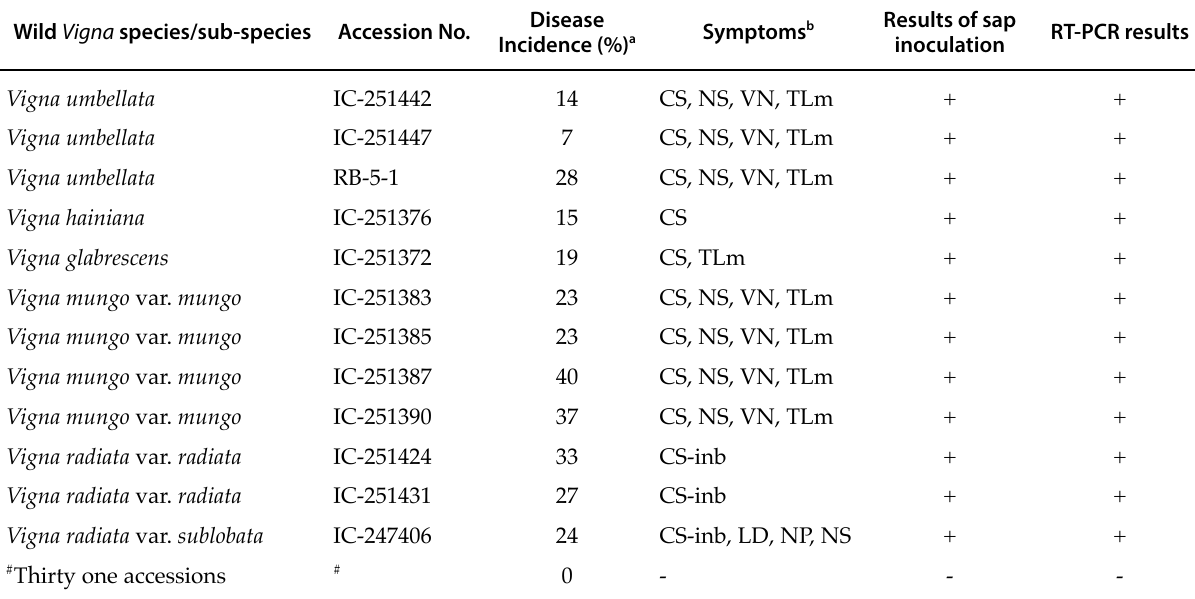
Table 2. Wild Vigna accessions, disease incidence, symptoms and RT-PCR detection of GBNV. Wild Vigna species/sub-species Accession No.